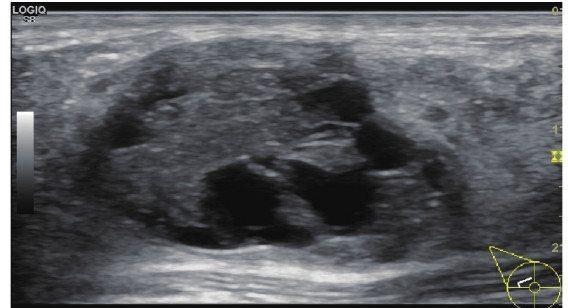
Figure 1 Ultrasound imaging of the breast showed a lobulated hypoechoic and no circumscribed margin mass with posterior acoustic enhancement and cystic areas within the